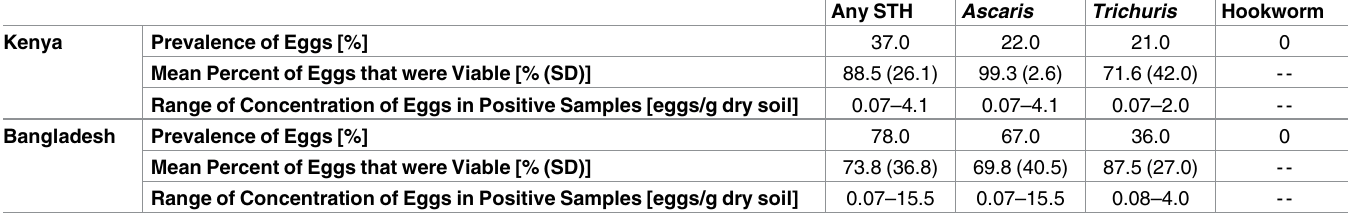
Any STH Ascaris Trichuris Hookworm